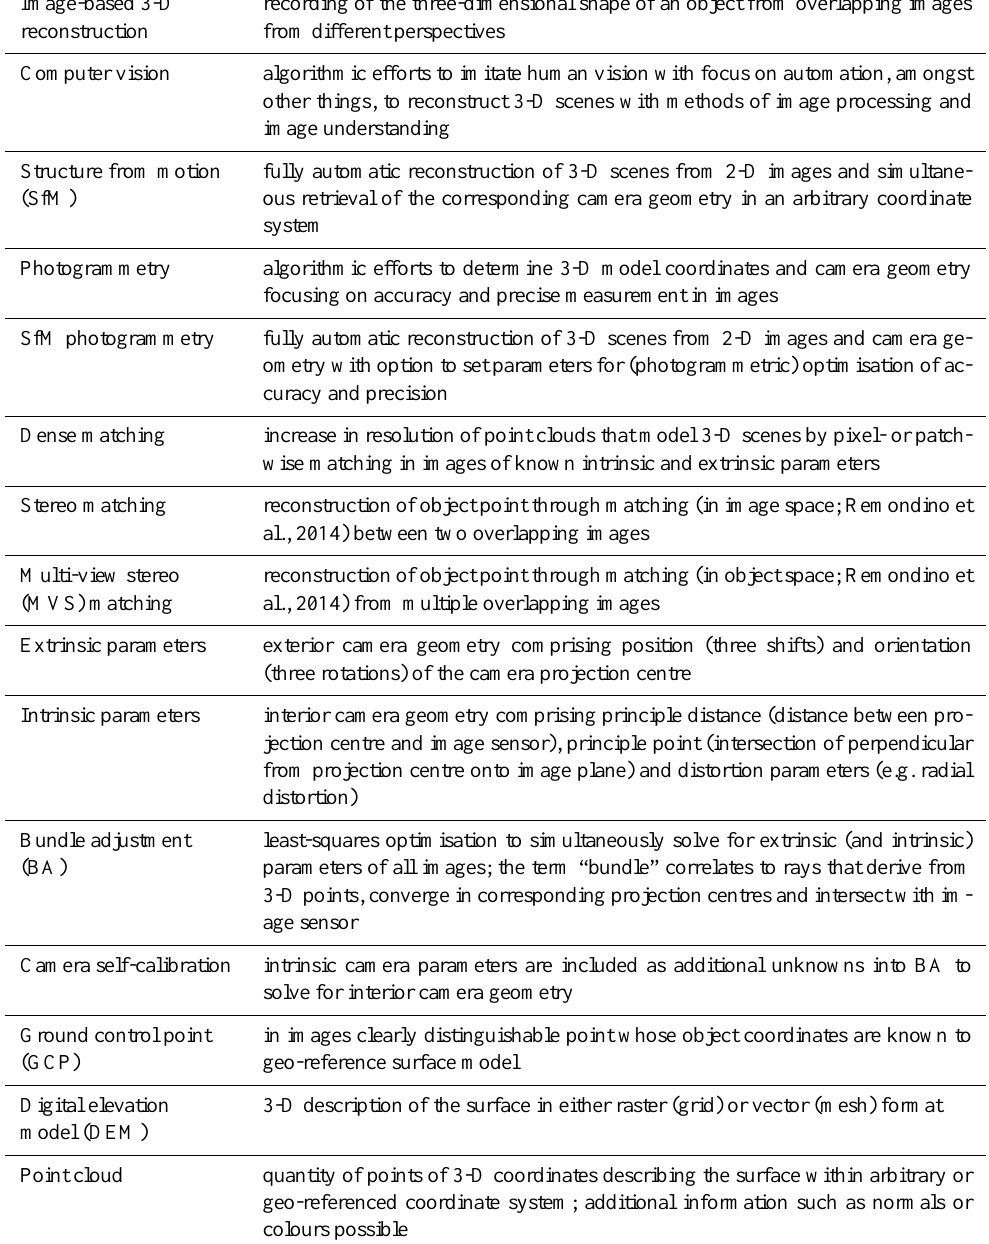
Table 1. Nomenclature and brief definitions of image-based 3-D reconstruction-related terms. Image-based